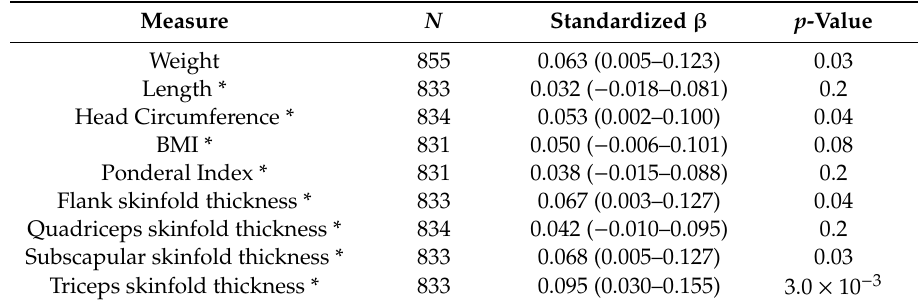
Table 2. Associations between maternal micronutrients supplementation status in pregnancy and indices of offspring size at birth.